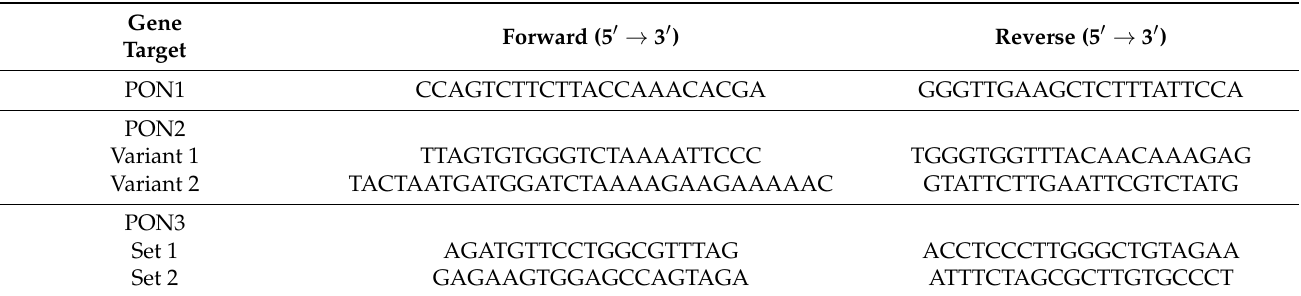
Table 1. Sequences of the primers designed for PCR.